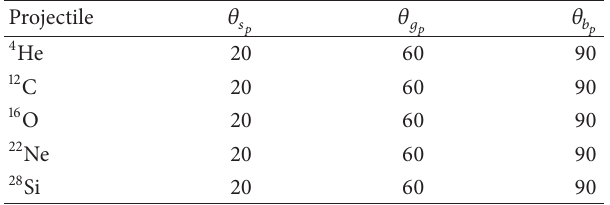
Table 6: The peak position of angular distributions for shower, grey, and black